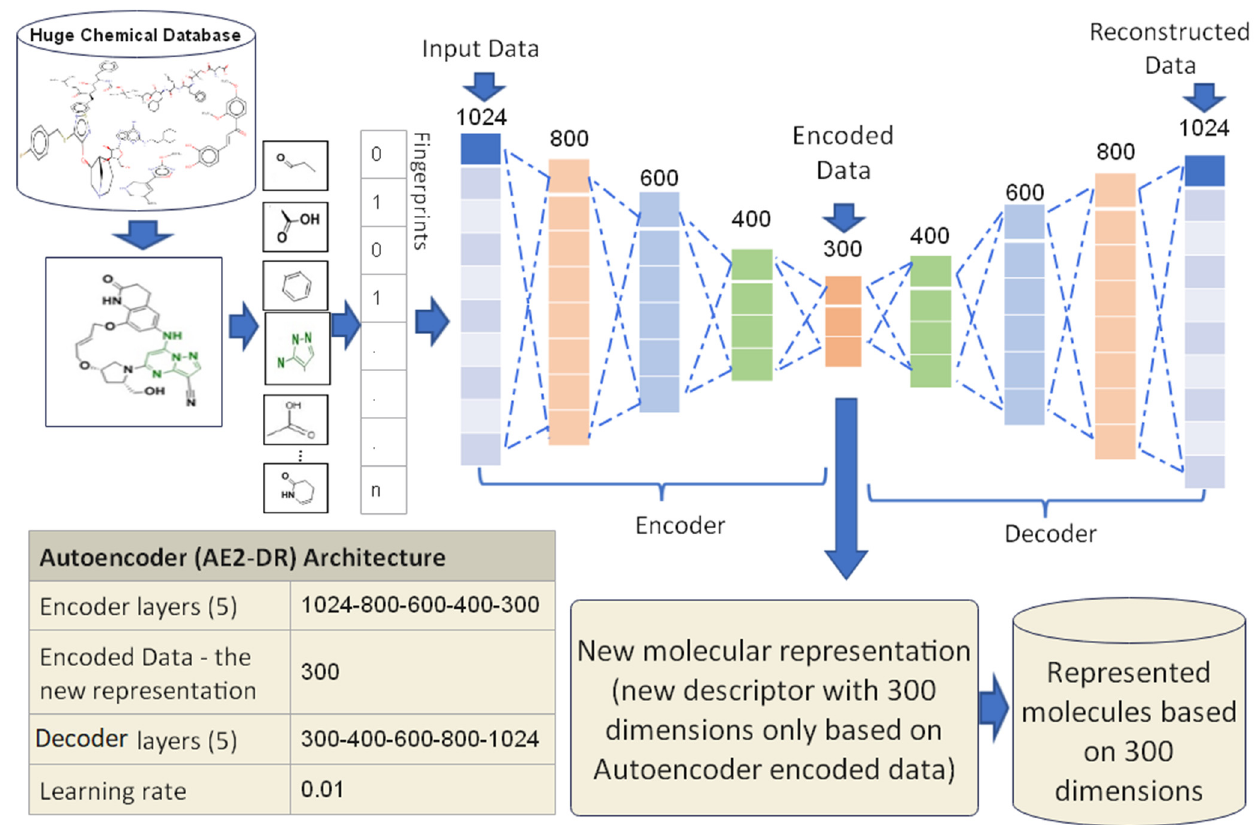
Figure 5. The AE2-DR proposed Figure 6. The AE2-DR proposed design.